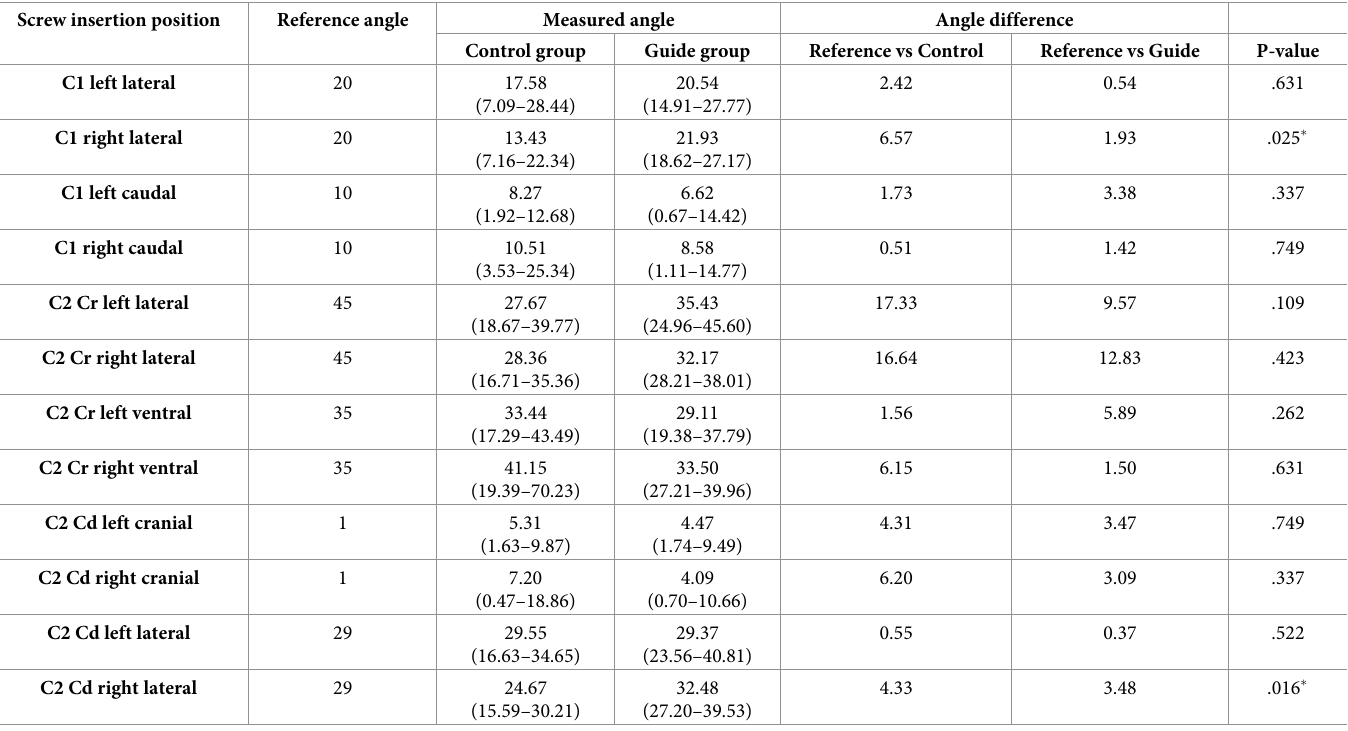
Table 3. Screw insertion